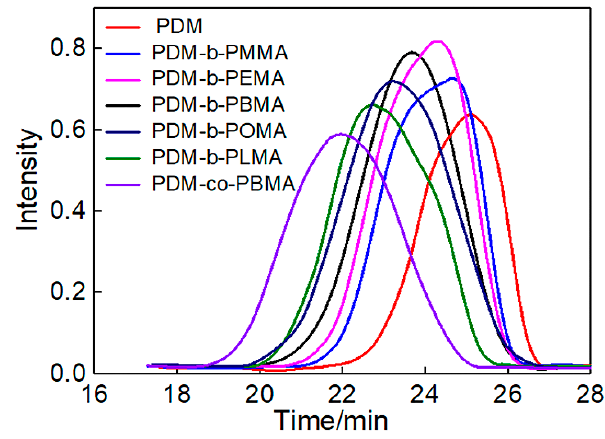
Figure 4. Effect of hydrophobic side chain (HSC) length on the molecular weight of PDM- b -PRMA.